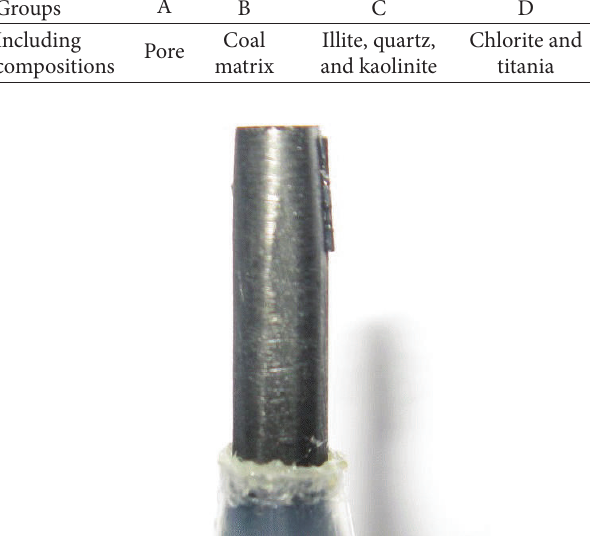
Figure 1: Coal sample used in this